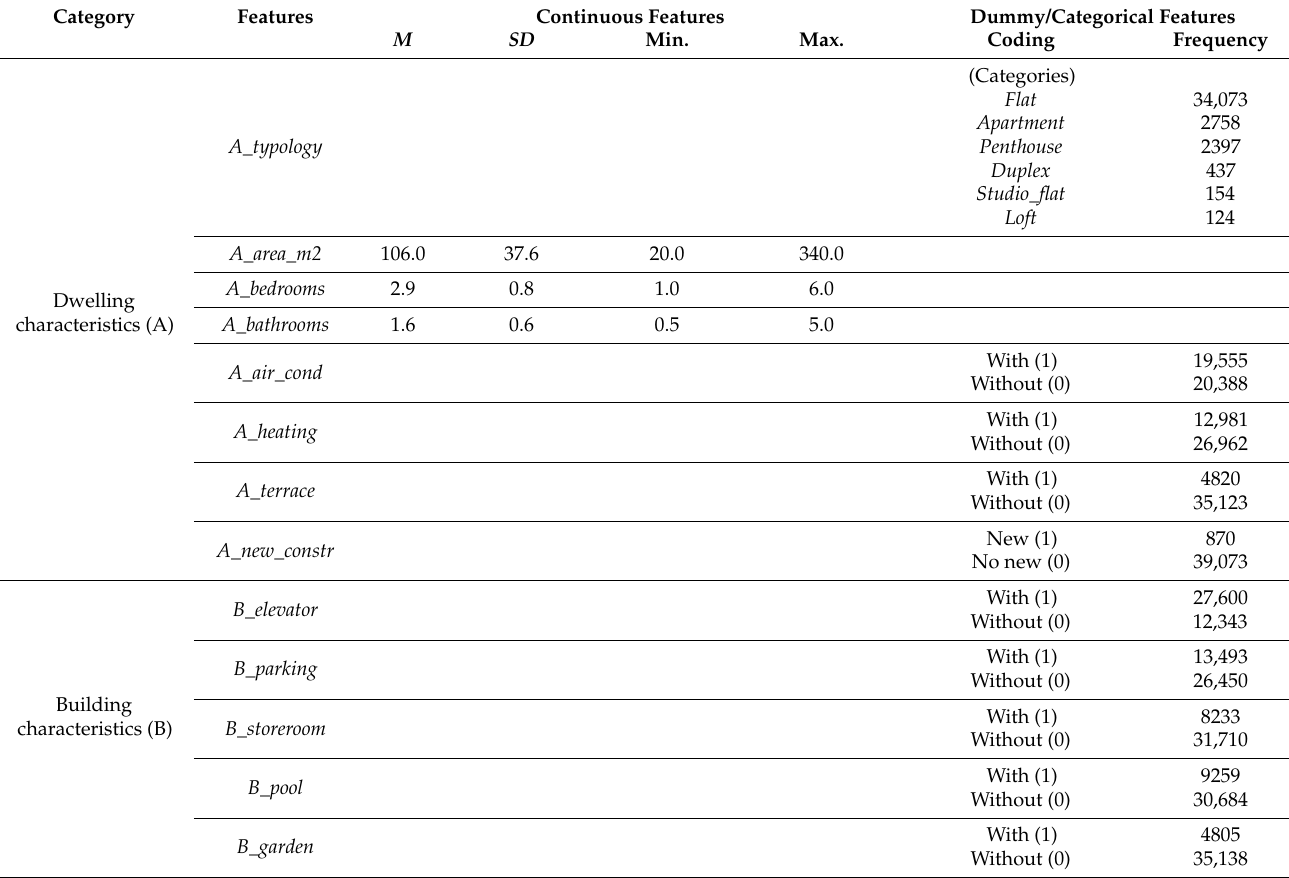
Table 2. Descriptive statistics for the